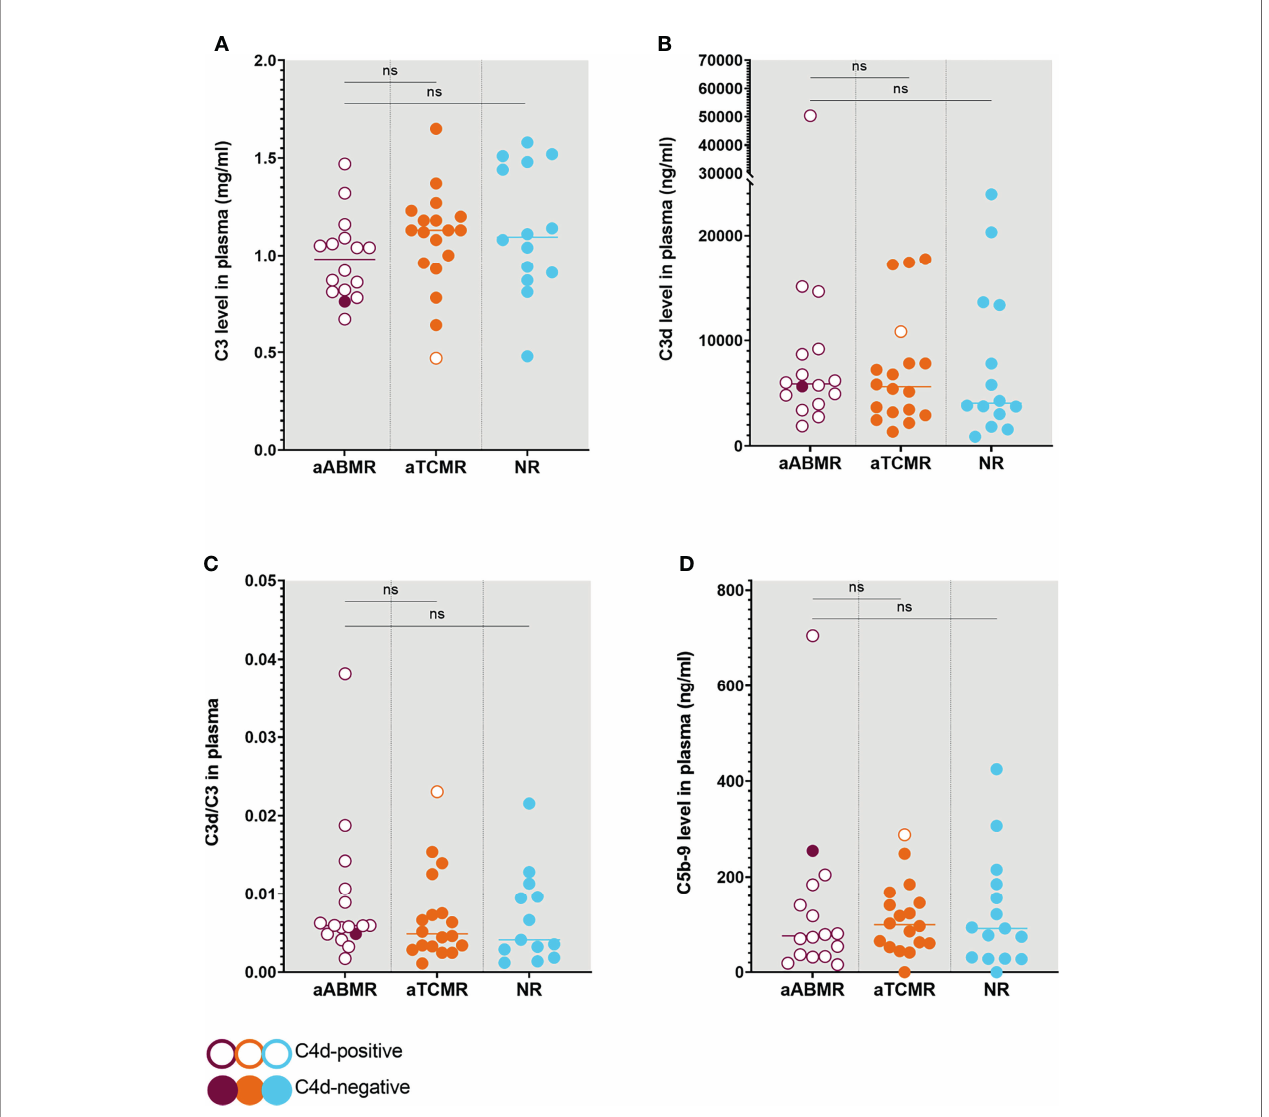
FIGURE 2 | Complement Levels in Plasma of aABMR, aTCMR, and NR patients. Plasma levels were measured for C3 (A) , C3d (B) , and C5b-9 (D) . Ratios were calculated from respective C3 and C3d levels (C) , indicating systemic complement consumption. Circles represent individual patients with open circles indicating C4d-positive patients and fi lled circles symbolizing C4d-negative patients. P values depict results from Mann-Whitney U statistical analysis. Statistical signi fi cance is de fi ned as P < 0.05. aABMR, active antibody-mediated Rejection; aTCMR, acute T-cell mediated rejection; NR, non-rejection; ns, not signi fi